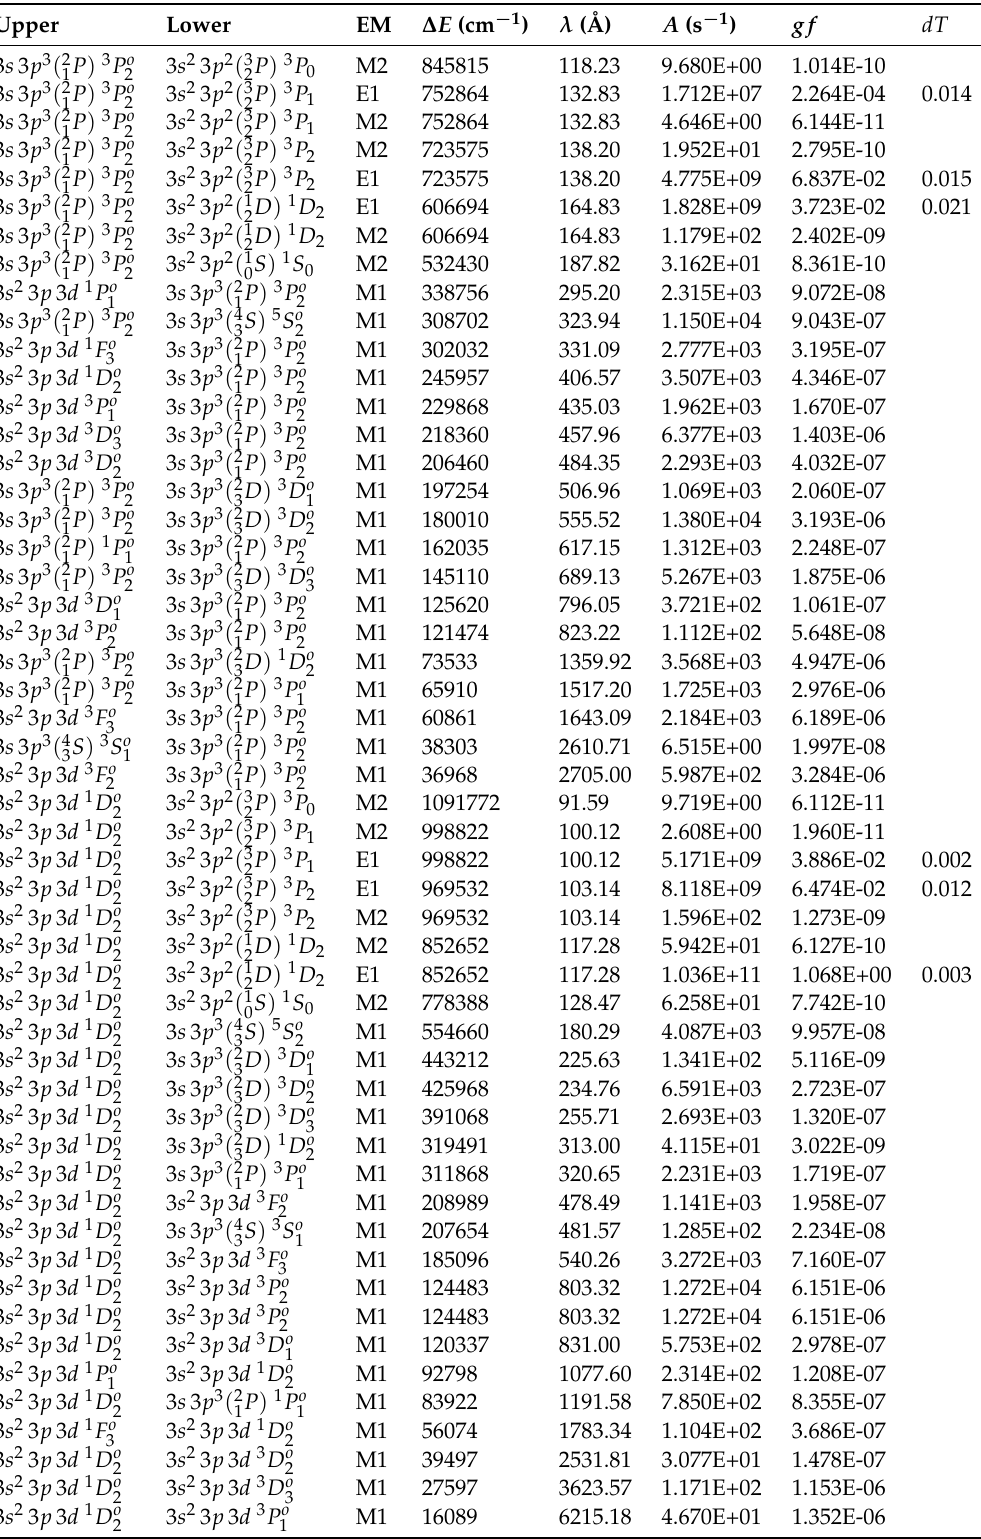
Table 2. Transition data for Si-like Sr where each level has been assigned a unique label.